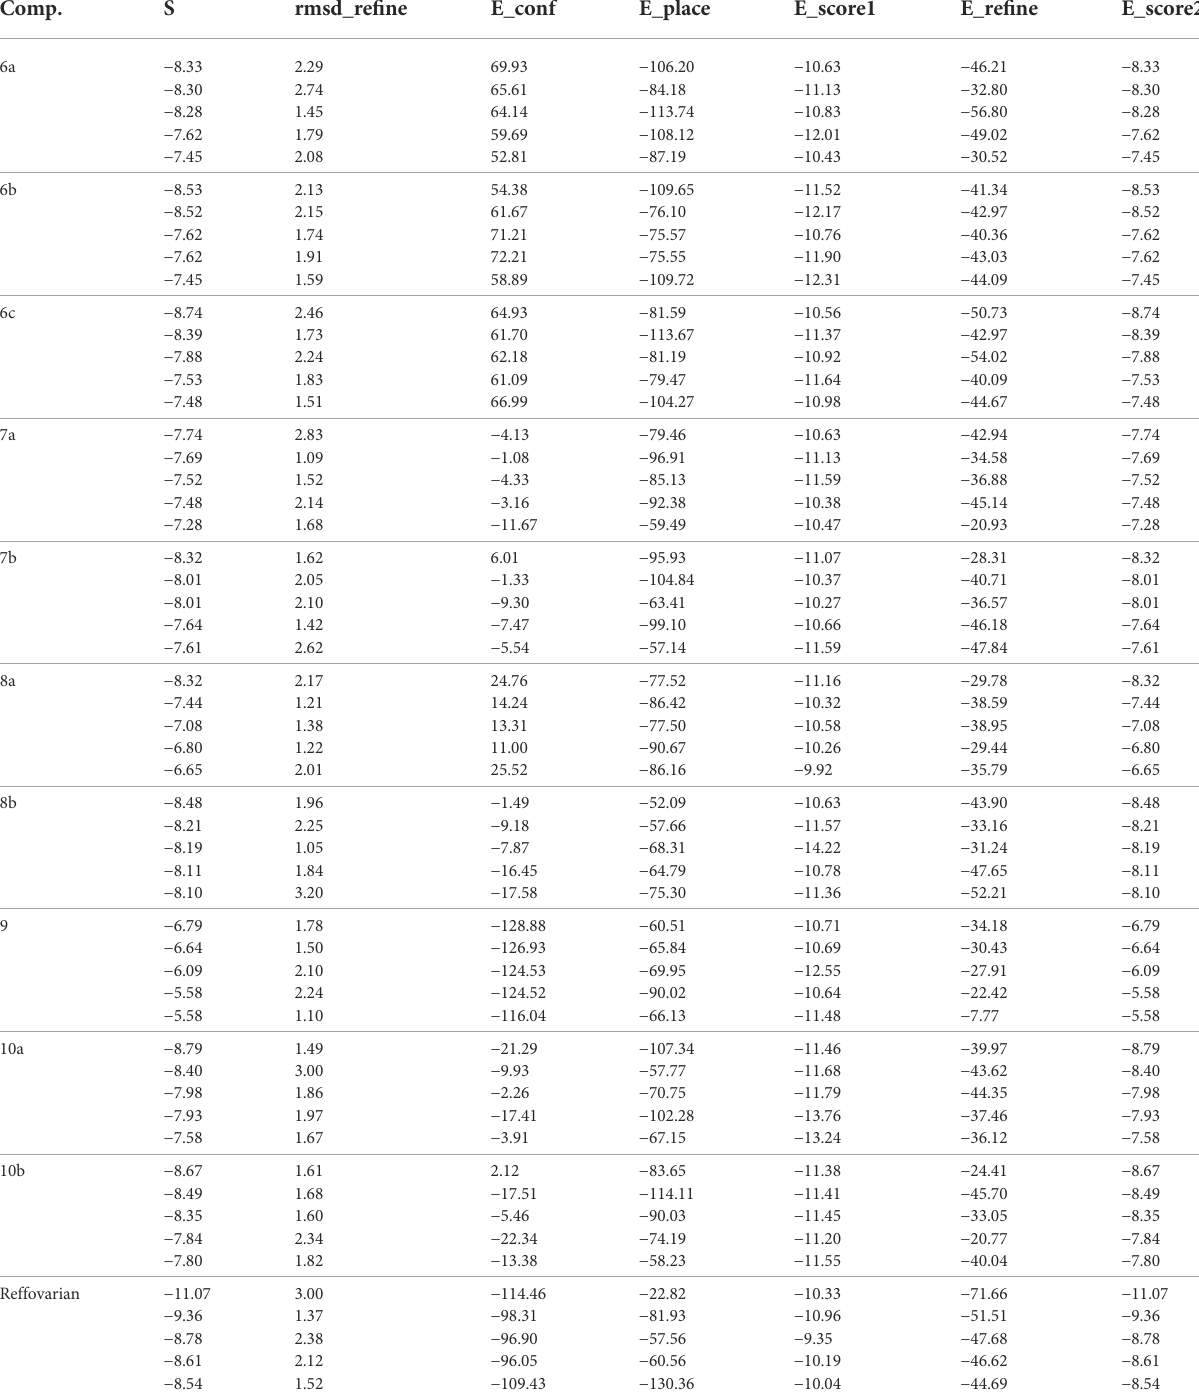
TABLE 3 Docking score and energies of All compounds with 3W2S “ ovarian cancer protein. ”